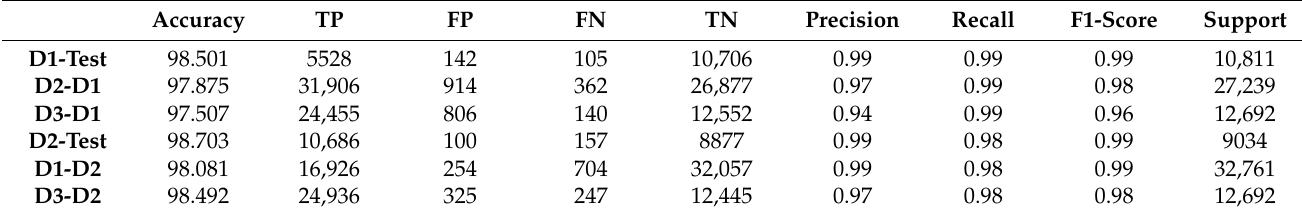
Table 5. Results of XGBoost ML